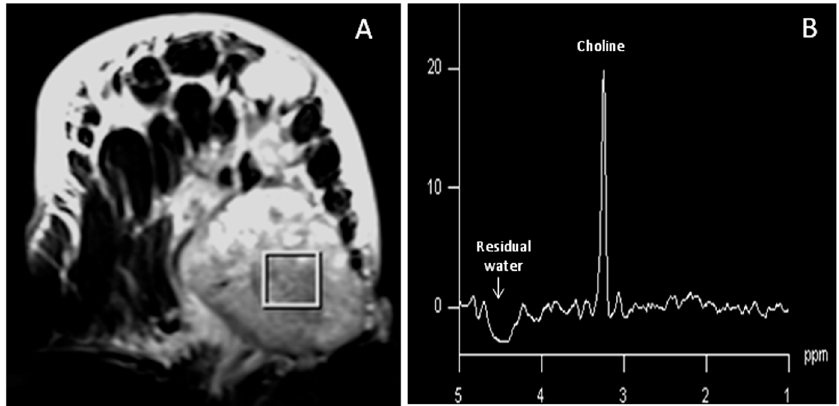
Figure 3. ( A ) T2-weighted, fat-suppressed axial image of a locally advanced breast cancer patient showing the location of a voxel of size 20 × 20 × 20 mm 3 from which the corresponding 1 H MR spectrum; ( B ) was obtained with water and lipid suppression (Reproduced with permission from John Wiley and Sons from reference [55]).